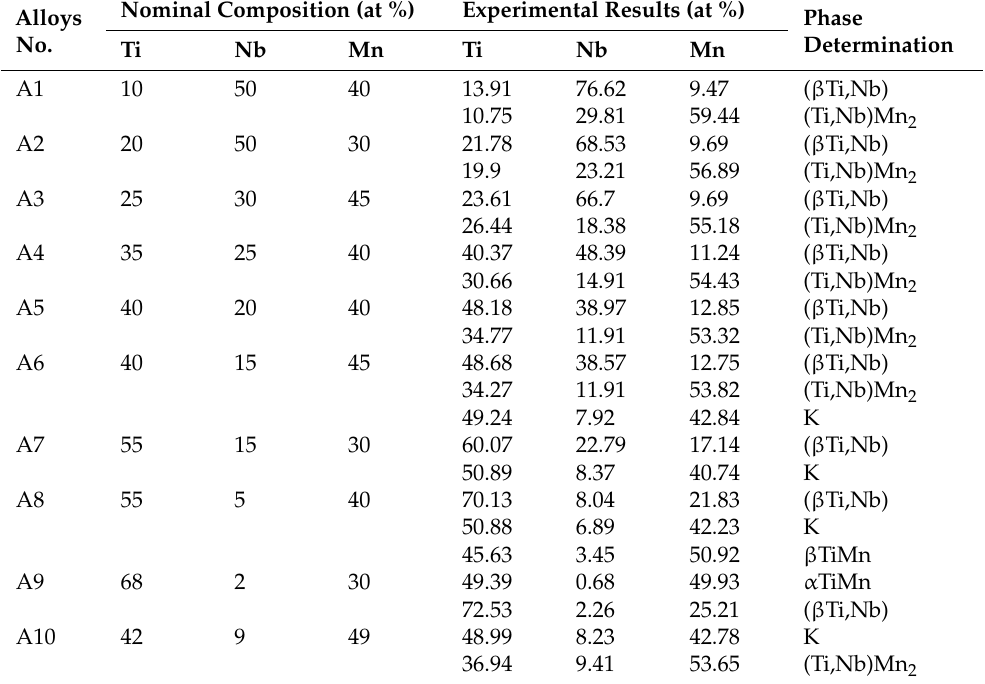
Table 2. Constituent phases and compositions in the annealed Ti-Nb-Mn alloys at 1173K for 90 days.